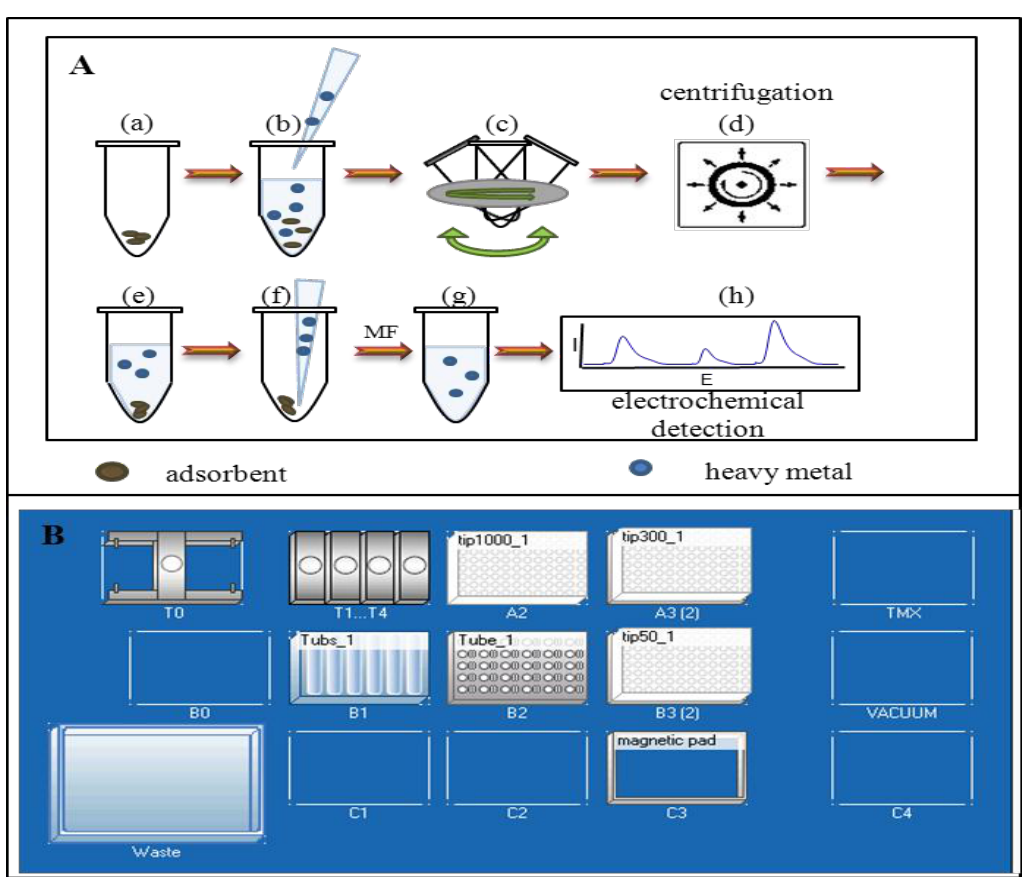
Figure 6. ( A ) Preparation of samples: (a) weighed adsorbent; (b) pipetting solution of heavy metal; (c) shaking the sample; (d,e) centrifugation of the sample; (f) pipetting of supernatant; (g) filtration with a MF (membrane filter); (h) electrochemical detection of heavy metal using differential pulse voltammetry. ( B ) Automatic preparation of samples on EpMotion 5075 (Eppendorf, Germany)—scheme of instrumentation workplace. T0 carrier (capacity ≤ 1200g), T1…T4 dosing machines: TS 1000, TS 300, TS 300/8, TS